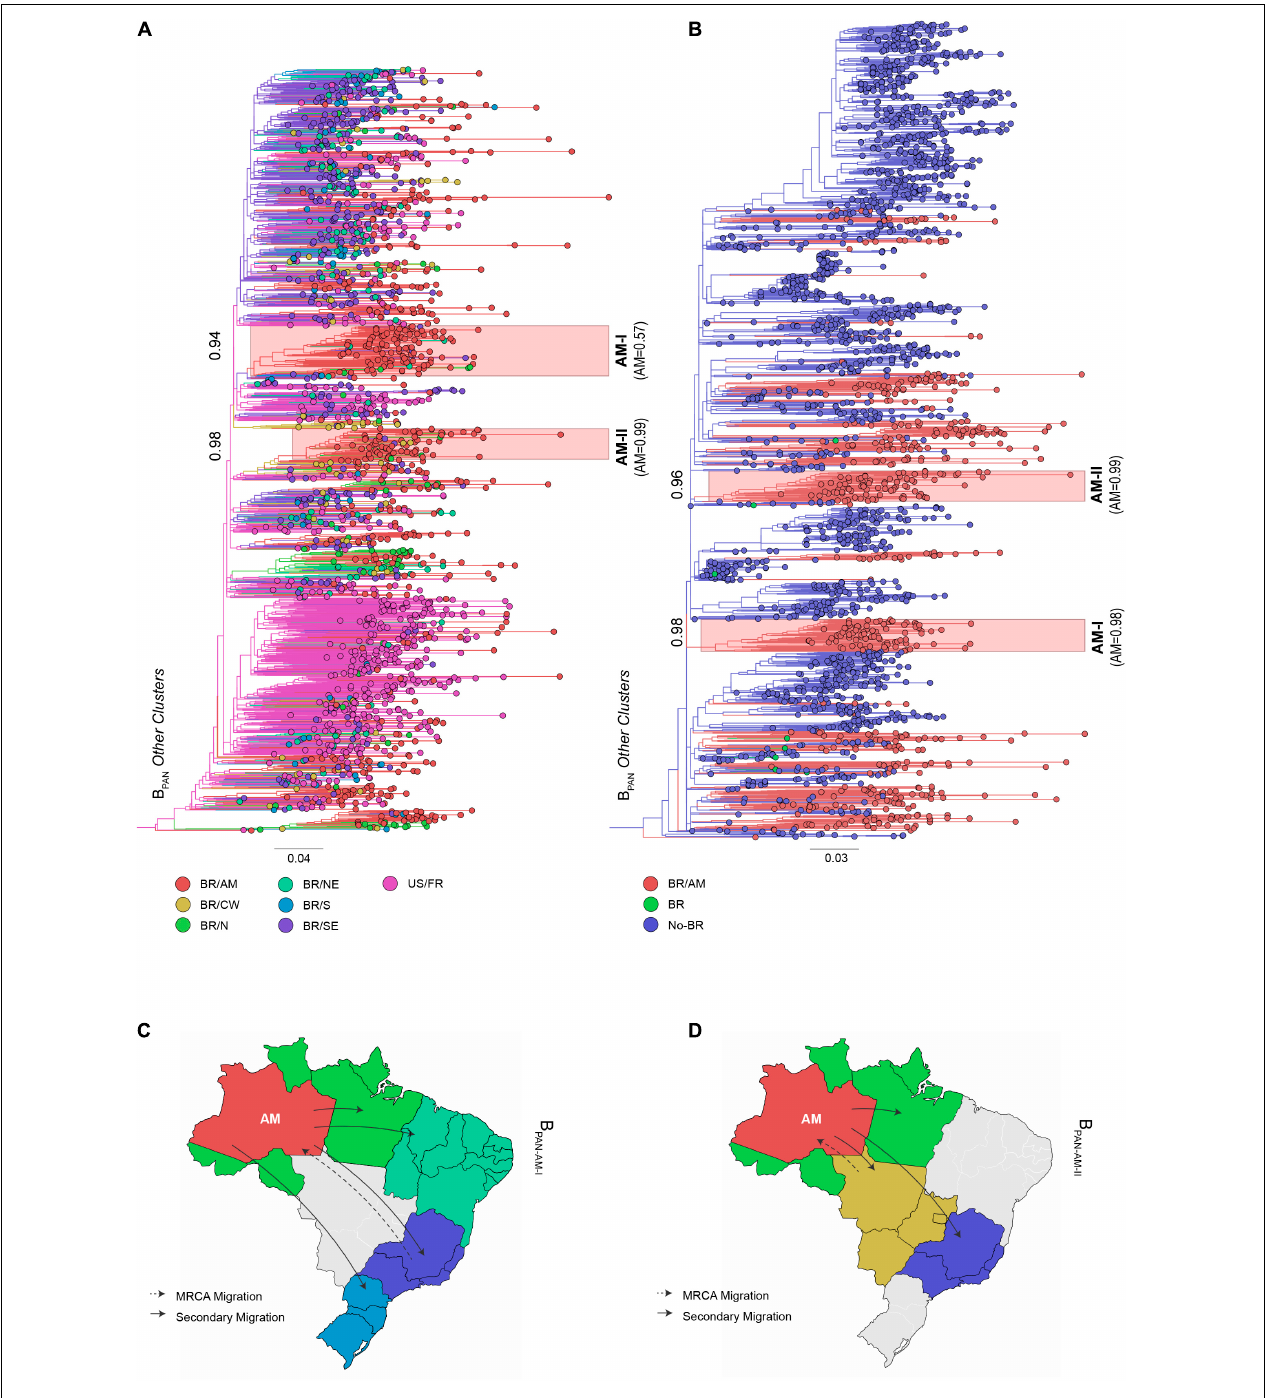
FIGURE 3 | ML phylogeographic analysis of HIV-1 B PAN Amazonian sequences that branched outside major Brazilian clades. A total of 530 B PAN sequences sampled in Amazonas were aligned with: (A) Closely related B PAN sequences sampled in other Brazilian states ( n = 687) plus reference B PAN sequences from the United States and France ( n = 498), and (B) closely related B PAN sequences sampled worldwide ( n = 1,683). Major Amazonian clades B PAN − AM − I and B PAN − AM − II are indicated by colored shaded boxes along with cluster aLRT support (number at basal branch) and the inferred marginal probability that cluster ancestor was located in Amazonas state (in parenthesis). The location of taxonomic units at internal nodes across the ML tree was reconstructed and represented according to the color scheme shown in the map. Sequences were grouped in seven (A) and three (B) discrete locations: Amazonas state (AM), Central-Western region (CW), Northern region (N); Northeastern region (NE), Southeastern region (SE), Southern region (S), United States/France (US/FR), other Brazilian states (BR), and non-Brazilian (Non-BR). Tree was rooted using HIV-1 subtype D reference sequences (not shown). The branch lengths are drawn to scale with the bar at the bottom indicating nucleotide substitutions per site. Major migrations of viral clades (C) B PAN − AM − I and (D) B PAN − AM − II are represented in the maps.